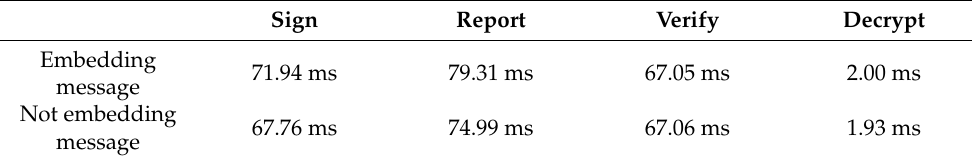
Table 3. Runtime of the sign, report, verification, and decryption